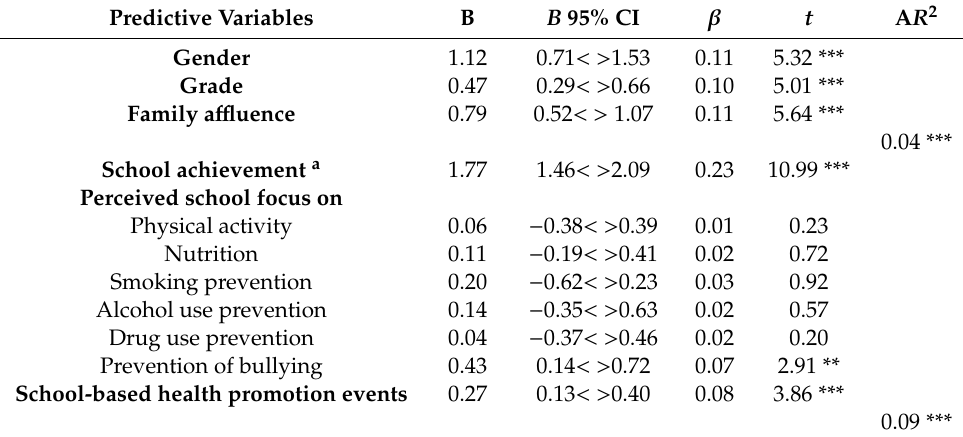
Table 3. Regression analysis predicting adolescents’ subjective health